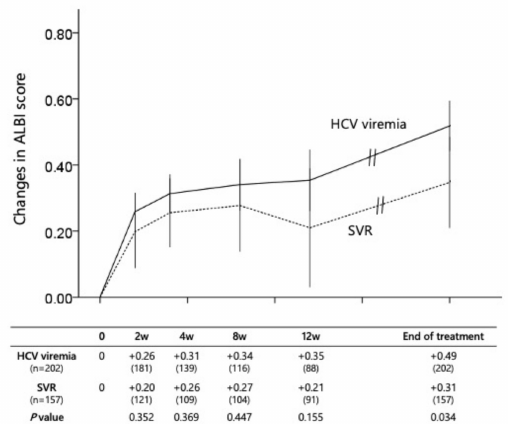
Figure 3. Dynamics of ALBI score during first systemic chemotherapy: SVR vs. HCV